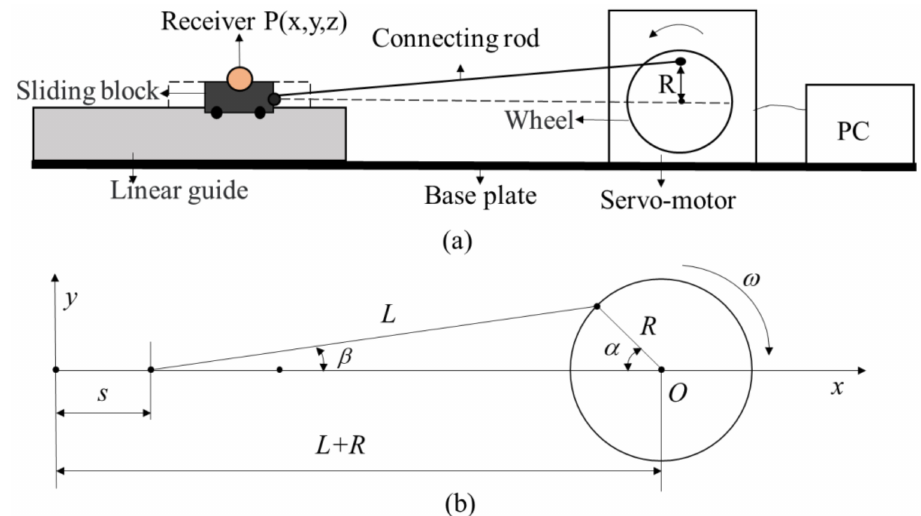
Figure 4. Simplified structure of the test and displacement analysis diagram. ( a ) Simplified structure of the test; ( b ) slide motion analysis